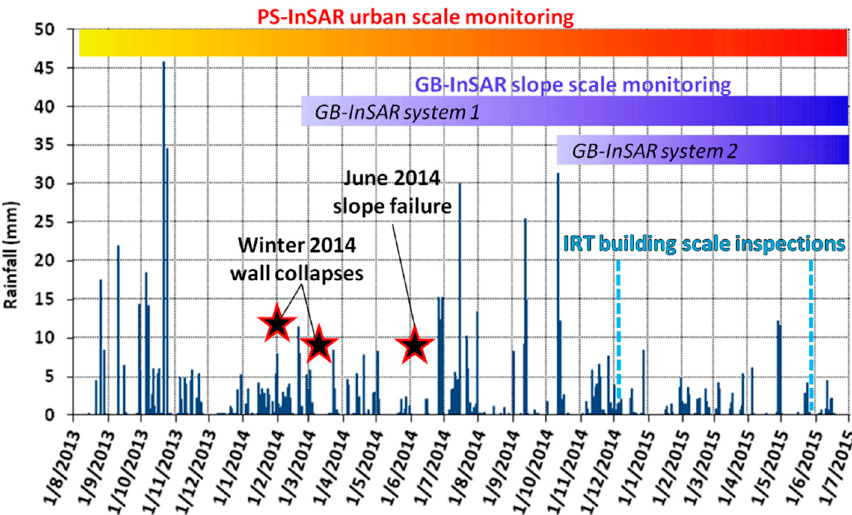
Figure 3. Time line of the employed multiplatform monitoring system, with city area rainfall data. Date format: dd/mm/yyyy.